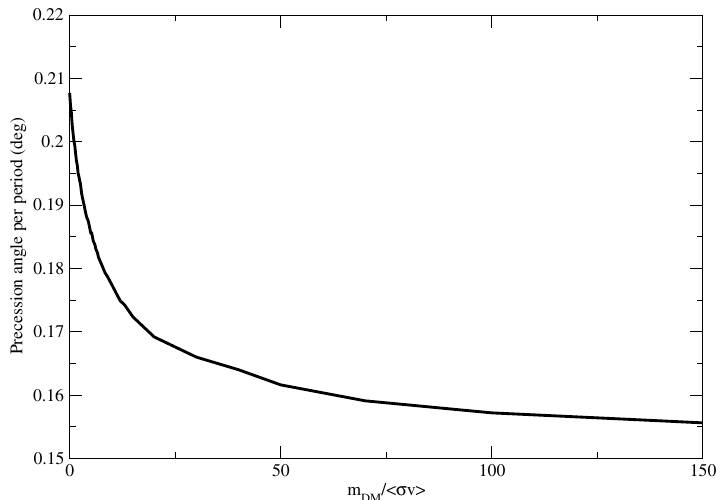
Figure 2. The black solid line indicates the variation of the precession angle of the S2 star per period against the parameter m DM / (cid:31) σ v (cid:30) . Here, the value of the m DM / (cid:31) σ v (cid:30) is normalised by the ratio 100 GeV / 2.2 × 10 − 26 cm 3 / s